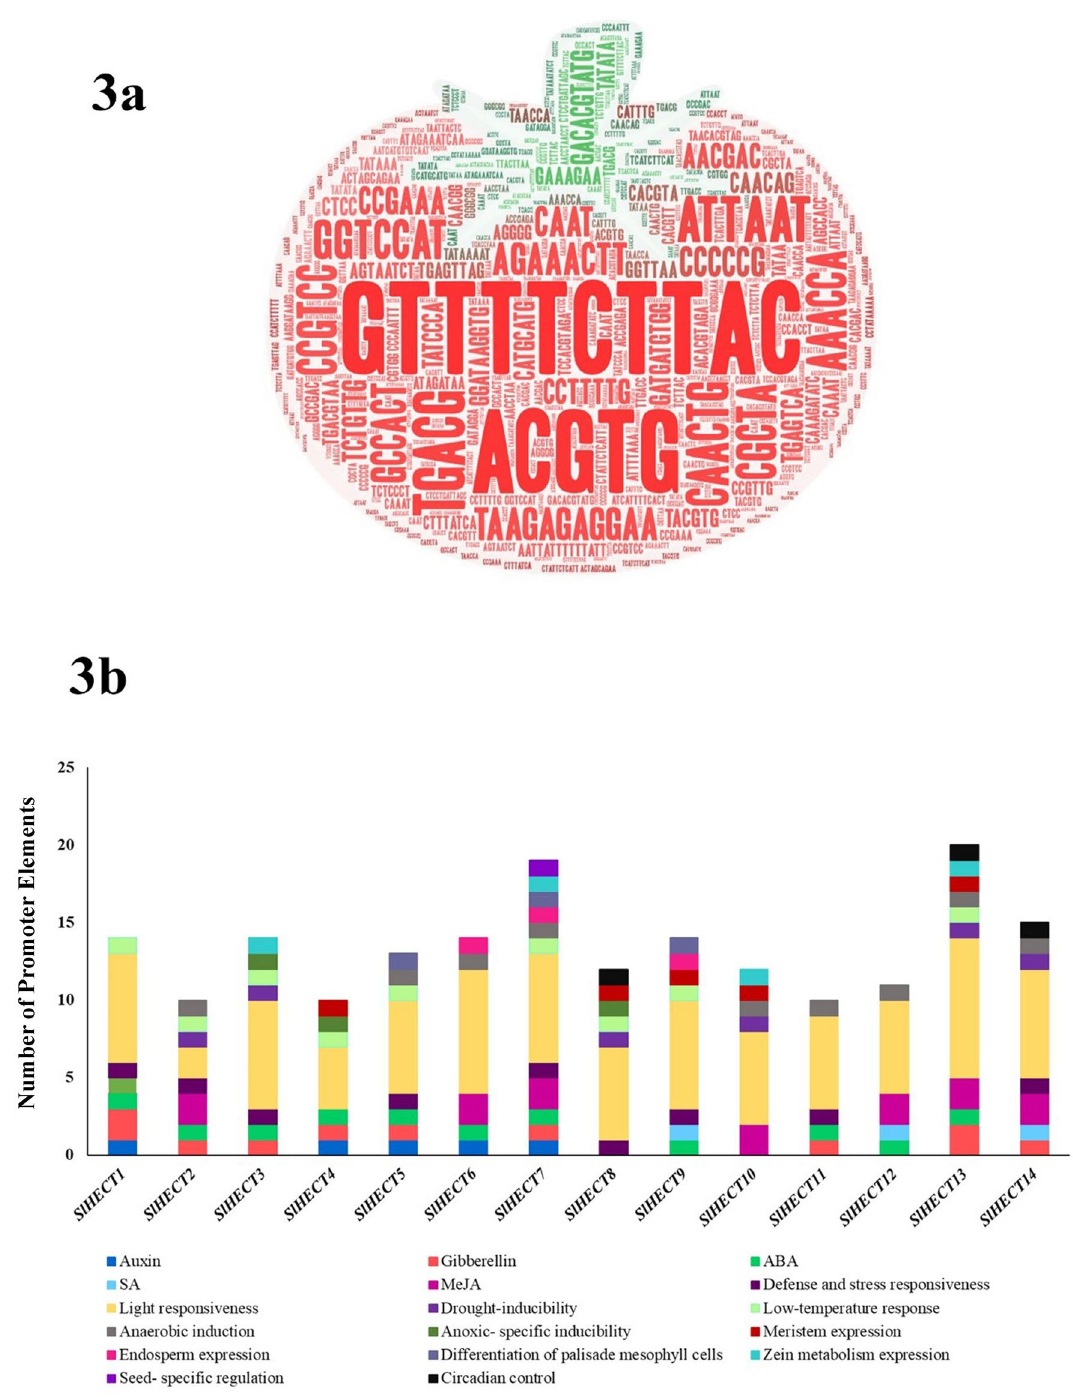
Figure 3. ( a ) Word cloud representing different cis-regulating elements present at 2000 bp upstream of HECT E3 ligase gene sequences ( b ) Graphical representation of fourteen HECT E3 ubiquitin ligase genes having varying roles in hormonal responses, abiotic stresses, plant development, defense, and stress